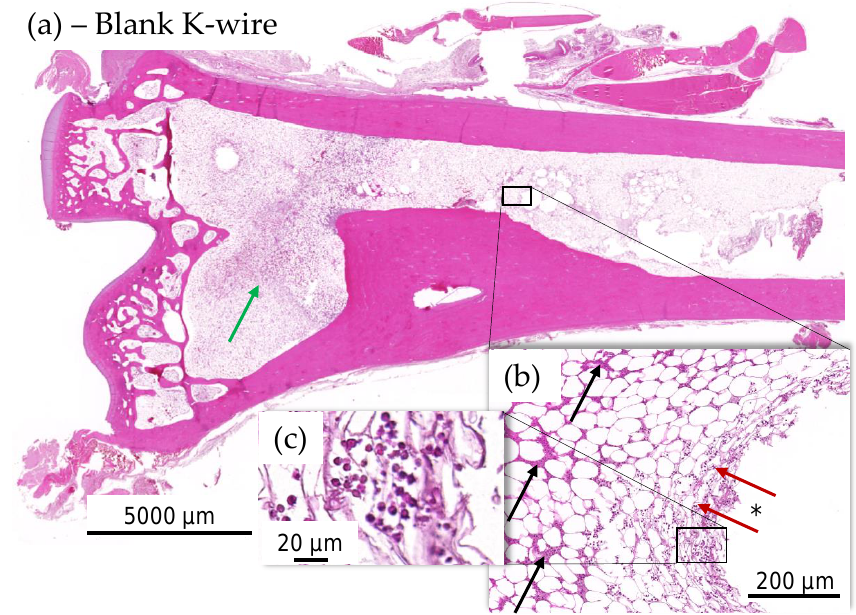
Figure 8. ( a – c ) Histology images of distal tibia of blank item animal. ( a ) There was a higher incidence of mild focal ongoing osteomyelitis in the distal tibia of blank K-wire implanted animals ( b ). Green arrows indicate new fibrous tissue (fibroplasia). Osteomyelitis was focal and showed evidence of several days old pus (black arrows) at periphery of implant, in the bone marrow and more recent exudate of intact and degenerated heterophils (red arrows and ( c )) in the bone marrow immediately adjacent to the implant imprint (*), indicating active suppurative inflammation.